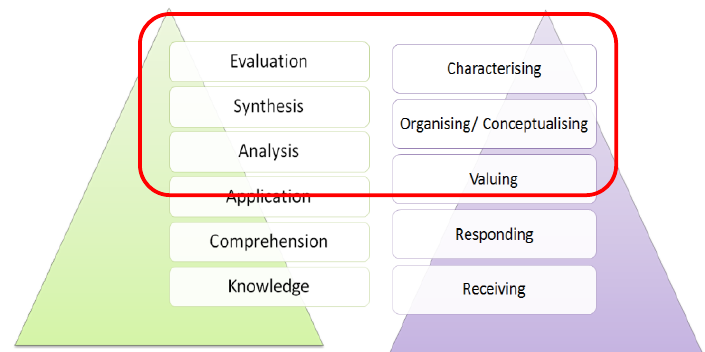
Figure 3 Bloom’s Taxonomy of Learning: Cognitive (L) and Affective (R) Domains (Bloom et al., 1956; Krathwohl et al, 1964)